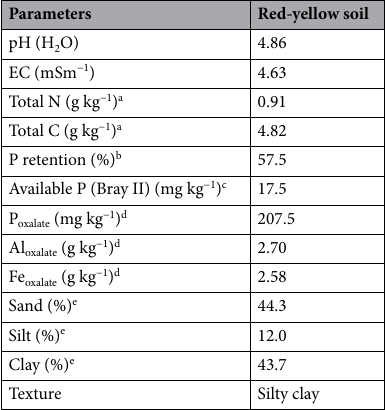
Table 1. Physicochemical properties of soil. a NC analyzer, Sumigraph NC-220F (SCAS, Japan); b The proportion of absorbed P after shaking 5 g of soil with 25 ml of 1000 ppm P solution for 24 h; c UV spectrophotometer (UV-1800, Shimadzu); d Inductively coupled plasma mass spectrometer (ICPE-9000, Shimazu, Japan) after oxalate extraction. e Sieving and pipetting